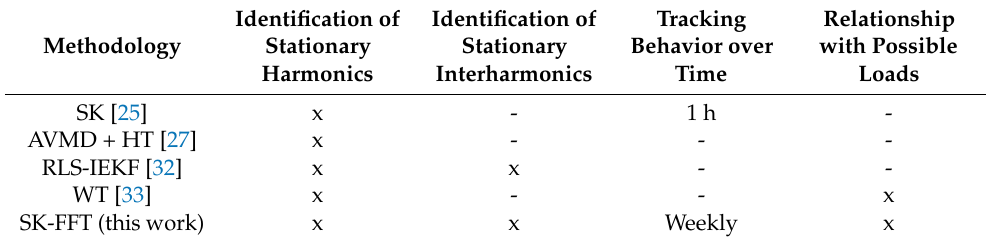
Table 2. Comparison of the proposed methodology with previous